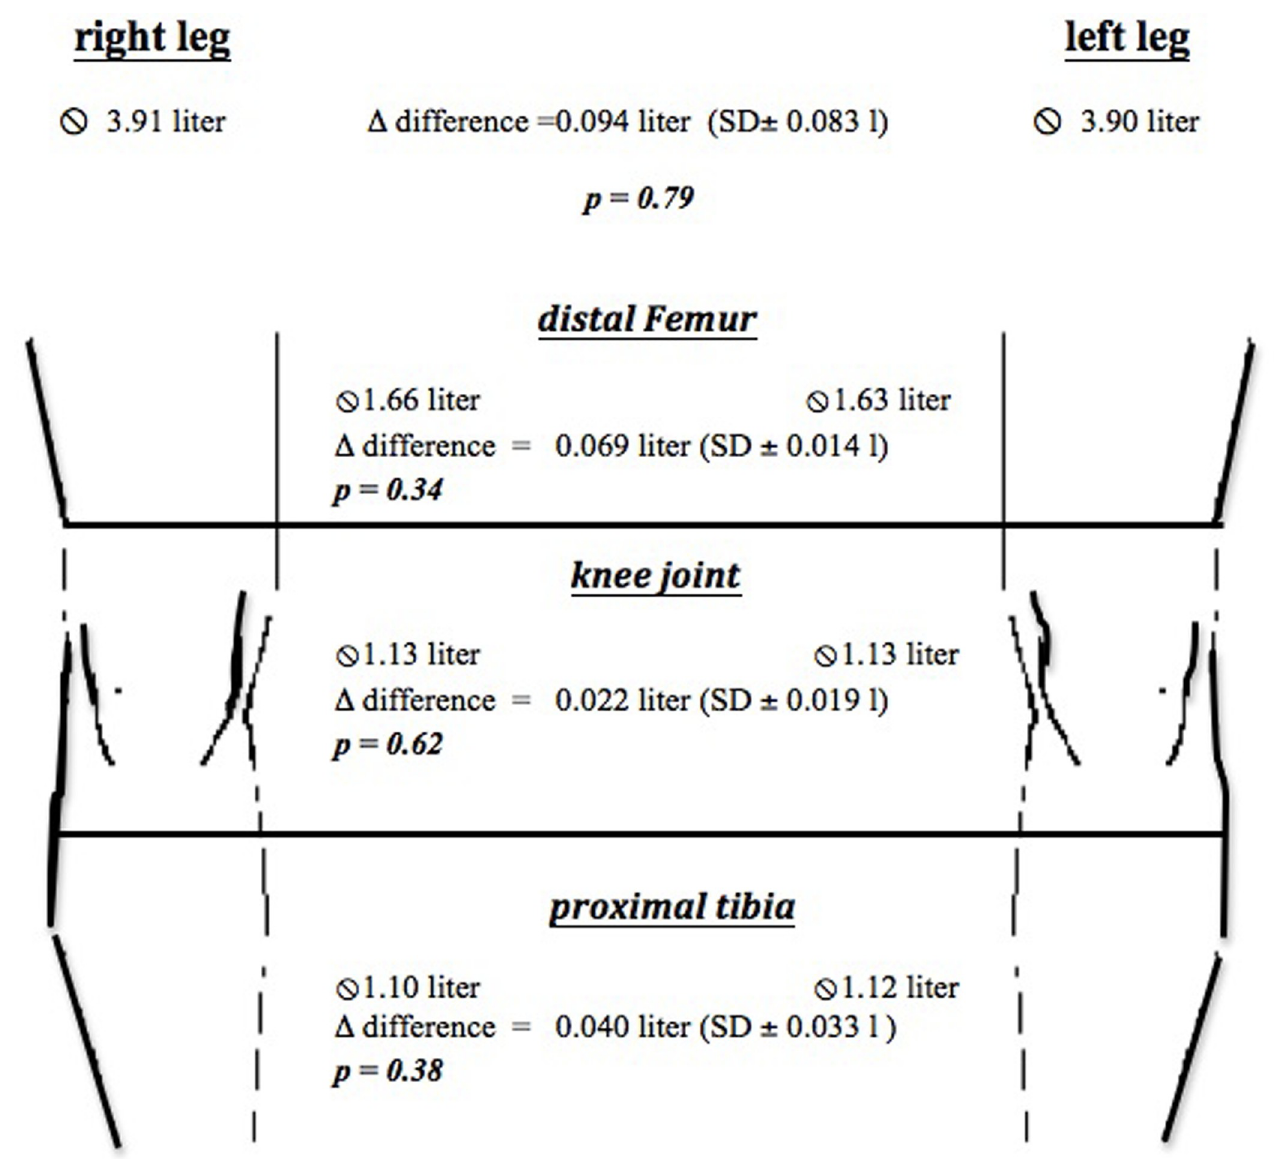
Fig 4. Comparison of the three ROI between right and left knee joint. 3D scanning of the knee indicating the measured volumes 20 cm proximal and 10 cm distal from the tibial tuberosity (starting point). The volumes were subdivided into segments of 2.5 cm. The Wilcoxon-Mann-Whitney test showed no significant differences of the volumes between the right and left leg (Overall leg volume: p = 0.79, I. distal femur: p = 0.34, II. knee joint: p = 0.62, III. proximal tibia: p = 0.38, Fig 3). No significant volume differences between supporting and free leg were found (p > 0.05).